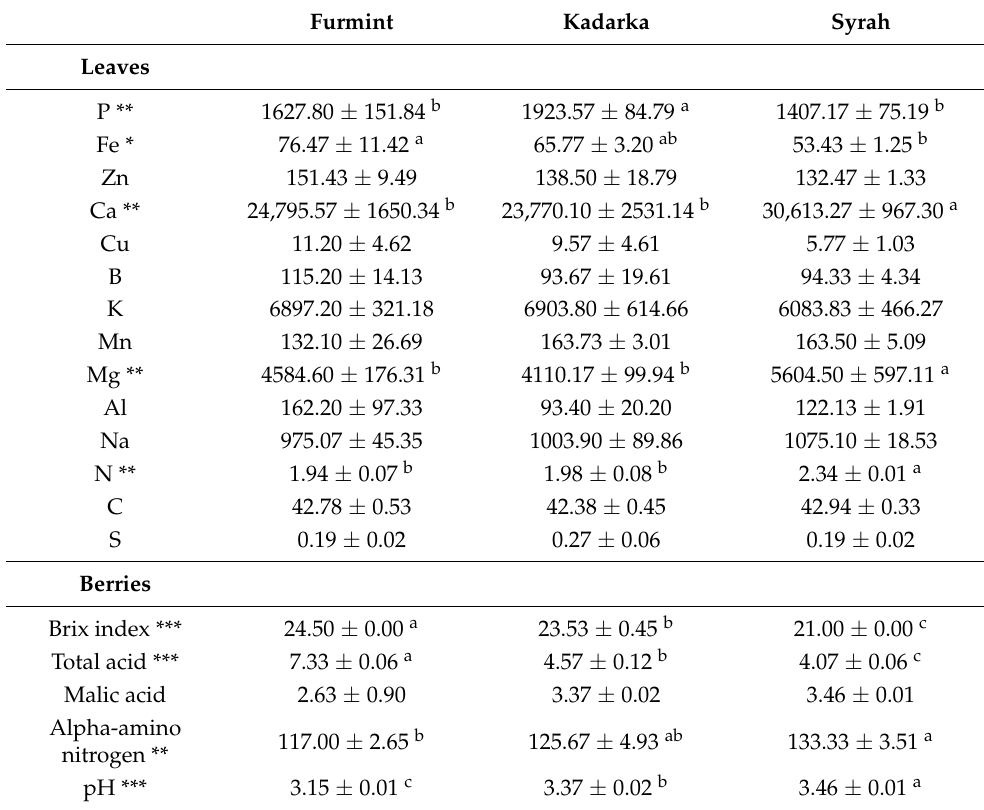
Table 2. Chemical parameters of leaf and berry samples from the three investigated grapevine cultivars: Furmint (F), Kadarka (K), and Syrah (S).